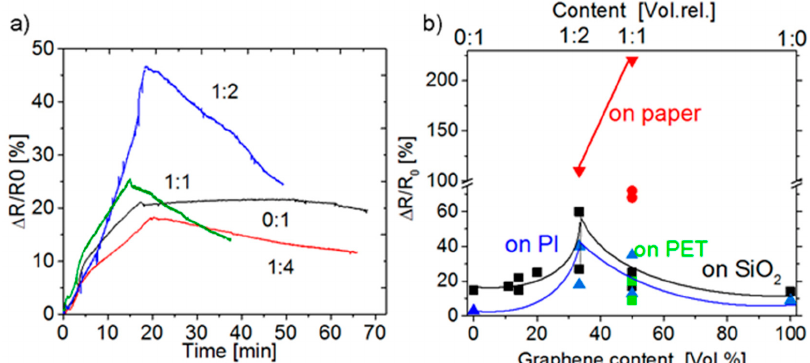
Figure 3. ( a ) The relative change in the resistance of a G: PEDOT: PSS composite film as a function of time during the variation of air humidity in the measurement chamber from 30% to 90%. The humidity was changed linearly with time. The content of the composite layer printed using the ink prepared from a suspension of graphene and PEDOT: PSS is shown at the curves as a parameter. Humidity was measured with an HIH4000 industrial humidity sensor. ( b ) The dependence of the response of the structures printed on di ff erent substrates on the composition of the film. The thickness of the films printed on paper was ~7 and 3 µ m (triangles and circles, respectively), and for the films on SiO 2 / Si and PI, about 3.5 µ